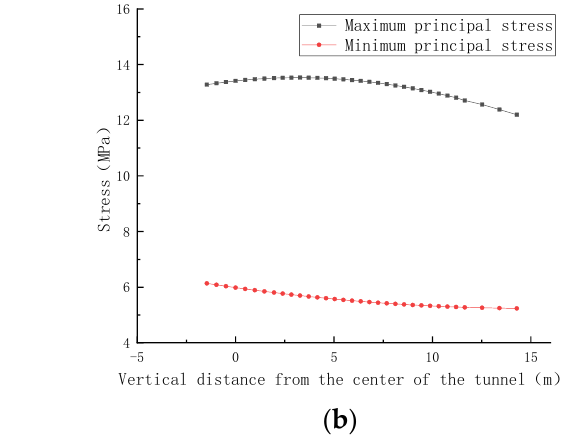
1 and σ 3 increase and then decrease from the residual coal pillar to the direction